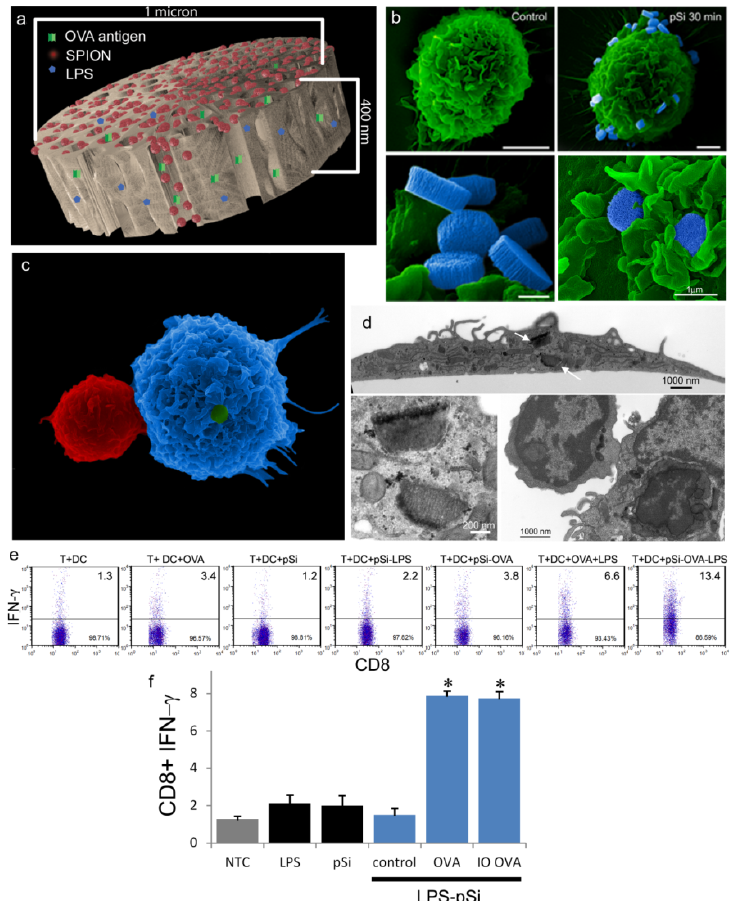
Figure 6. Hybrid particles as adjuvants for antigen presentation. ( a ) Computer simulated image showing SPIONs (red), ovalbumin peptide (OVA; green) and lipopolysaccharide (LPS) (blue) loaded into a pSi microparticle; ( b ) SEM images showing control and pSi microparticle-treated bone marrow-derived dendritic cells (BMDC) (30 min; bars 3 ( left ) and 2 µm ( right ); 10–13 k mag). High magnification images show a group of microparticles on the cell surface ( bottom left , bar 500 nm; 50 k mag) and two microparticles engulfed in BMDC membrane folds during early uptake ( bottom right ; bar 1 µm; 40 k mag); ( c ) SEM image showing particle adjuvant-induced association of a T cell with the stimulated BMDC; ( d ) TEM image showing a BMDC following treatment with LPS-pSi microparticles (3 h; bar 2 µm). The boxed region is shown at higher magnification in the lower left image, showing microparticles surrounded by cytoplasmic constituents. The bottom right image shows a T cell bound to a BMDC following treatment with adjuvant particles; ( e ) Flow cytometry dot blots showing the percent of interferon- γ (IFN- γ ) positive OT-1 CD8 + T cells following 4 h treatment with particle-stimulated (24 h) C57BL/6 BMDC (reproduced courtesy of Meraz et al. [24]); ( f ) C57BL/6 BMDC were incubated with various formulations of the hybrid particle vaccine then introduced to OT-1 T cells for 4 h, followed by analysis for intracellular IFN- γ production by flow cytometry ( n = 3). Controls included free LPS, unloaded pSi microparticles, and LPS-pSi microparticles, either empty (control) or loaded with OVA peptide, in the absence or presence of 20 nm SPIONS (abbreviated OVA and IO OVA) ( * p <